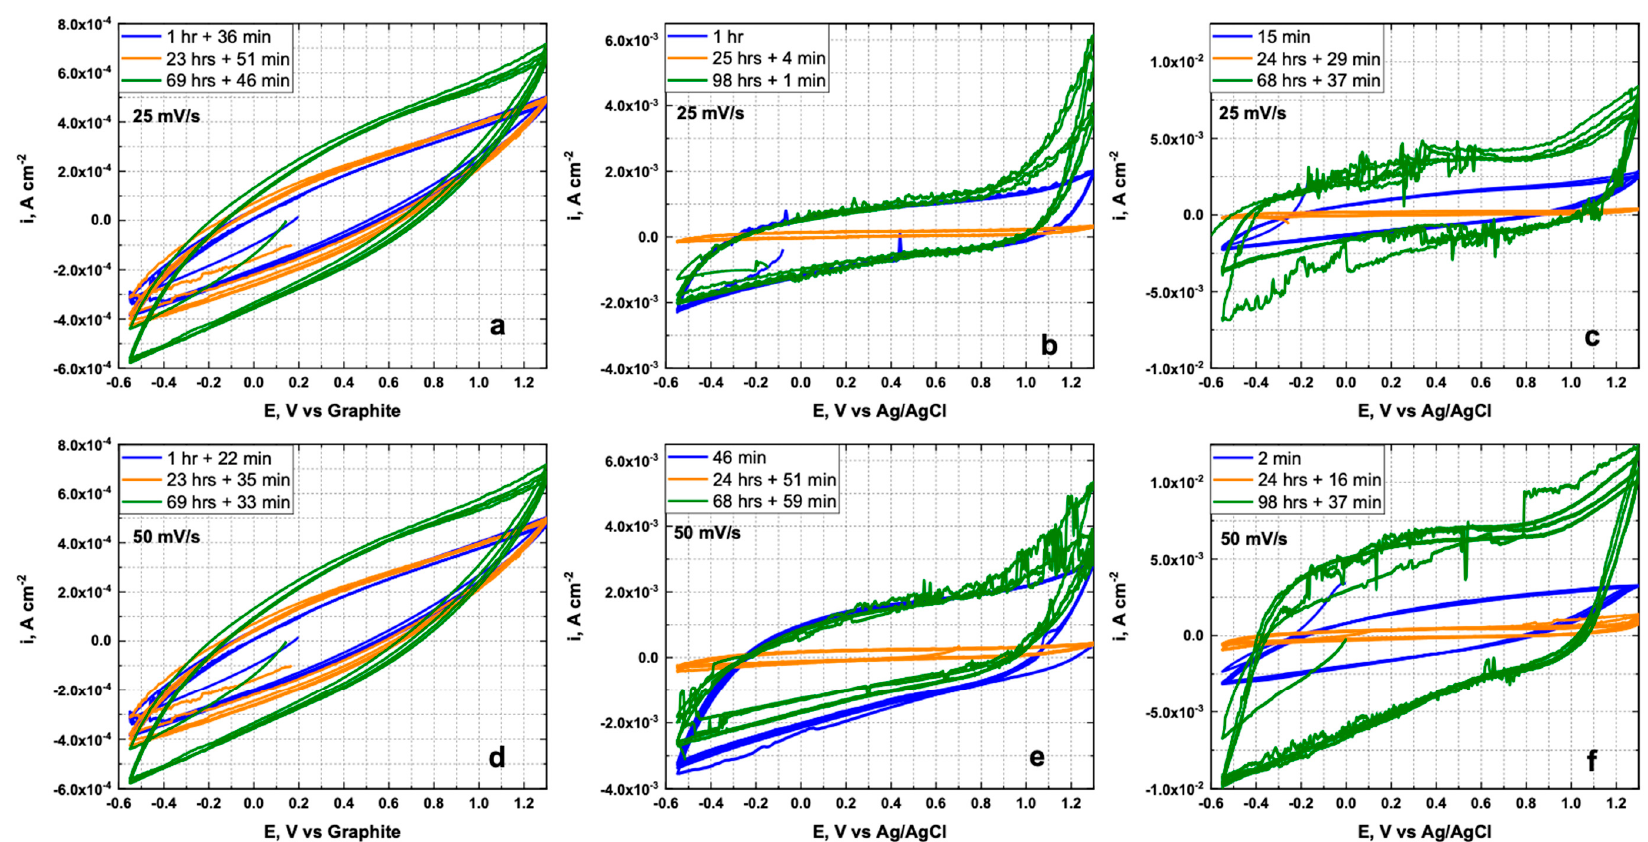
Figure 7. S 4: Electrochemical behavior of the MFC under non-pressurized conditions, at different reaction times and sweep potentials under cathode direction. The anode chamber was filled up with distilled water and the cathode chamber with a hydrochloric acid solution (0.1 M HCl, pH ≈ 1.8). ( a ) and ( d ), ( b ) and ( e ) and ( c ) and ( f ) correspond to the potentiostat settings A, B and C, respectively.